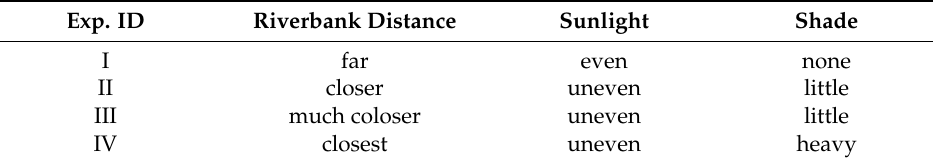
Table 3. Experimental